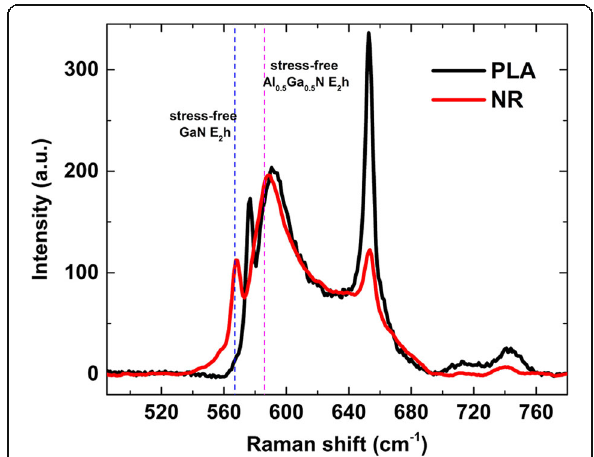
Fig. 5 Raman spectra of the PLA and NR samples stimulated by a 514 laser at RT. The black and red curves represent PLA and NR samples, respectively. The blue and pink dashed lines correspond to E 2 h peak of unstressed GaN and Al 0.5 Ga 0.5 N, respectively